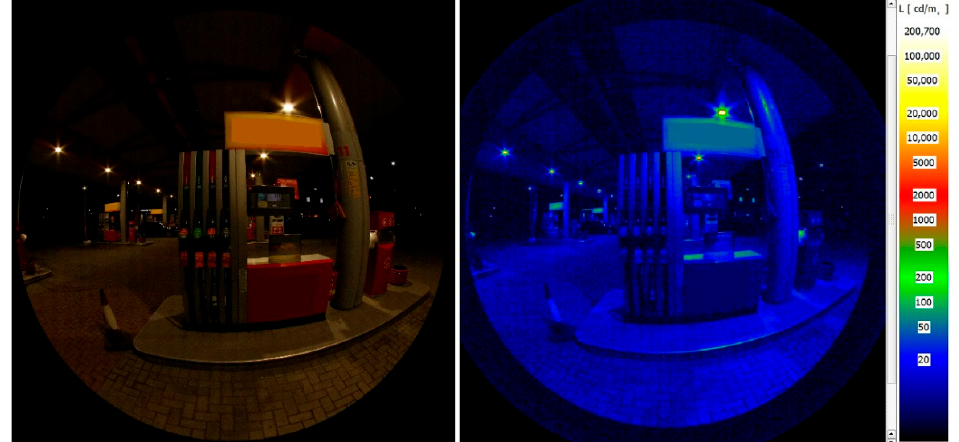
Figure 3. The view from the measurement point with corresponding luminance map. Measured GR = 29, subjective sensation of glare: just admissible, task of activity [5]: Meter reading area, GR MAX from standard [5] = 45.